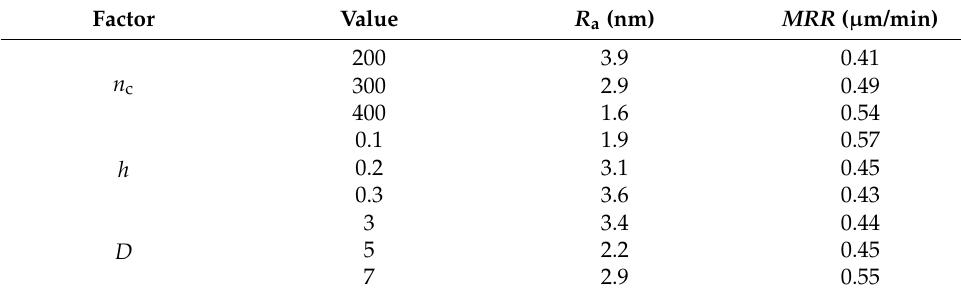
Table 3. Mean values at each level for each factor.